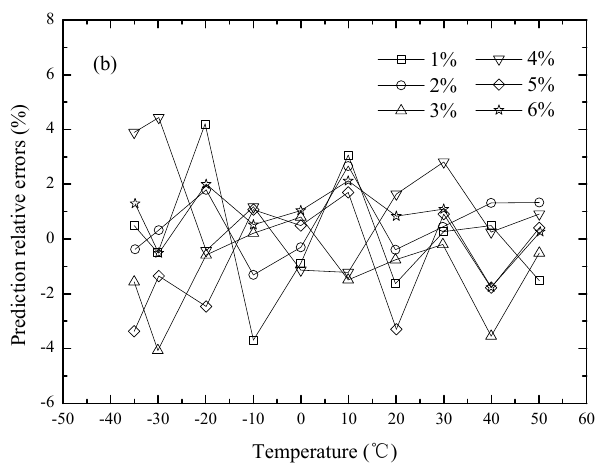
Figure 9. ( a ) Predicted comparisons and ( b ) relative errors of the RBF predicted μ nf / μ f and the experimental data [14] for CuO-ethylene glycol/water (60:40 by weight ratio) nanofluids at d p = 30 nm.